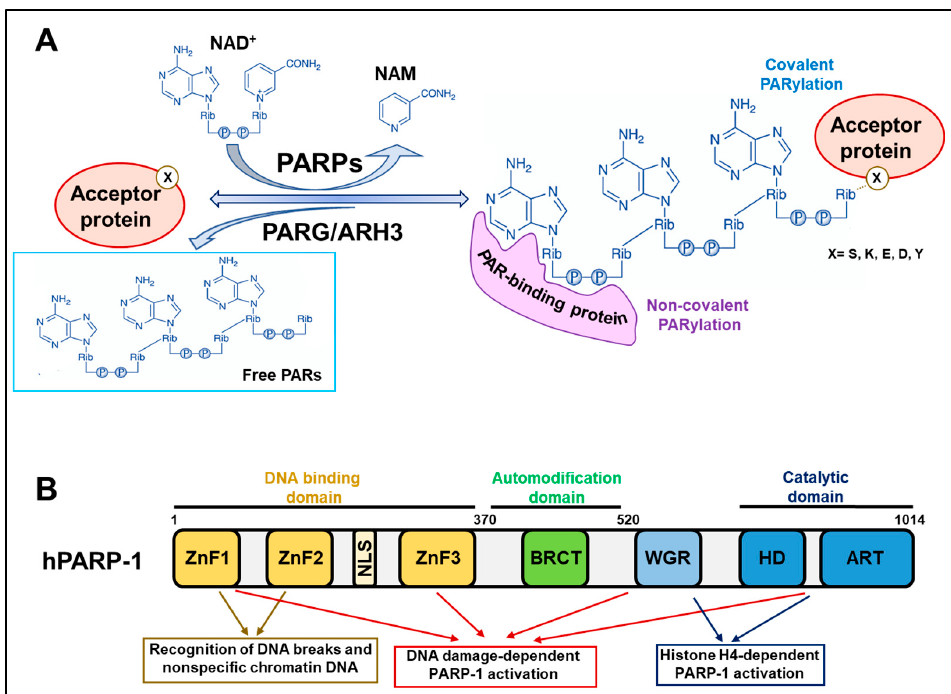
Figure 1 . Structural and functional characteristics of PARP ‐ 1. ( A ) PARP activity mediates covalent PARylation, catalysing the transfer of ADP ‐ ribose moieties from NAD + to several amino acid residues (X) on acceptor proteins releasing nicotinamide (NAM). The reversal reaction is catalysed by PAR ‐ hydrolysing enzymes, including PARG/ARH3. Different protein motifs or domains can recognise and bind PARs non ‐ covalently. ( B ) Schematic representation of the human PARP ‐ 1 molecular structure. The PARP ‐ 1 structure can be subdivided into three major domains: the NH 2 ‐ terminal DNA binding domain, the central automodification domain, and the COOH ‐ terminal catalytic domain. Other subdomains or motifs can be identified in the hPARP ‐ 1 structure: ZnF (zinc finger domain), NLS (nuclear localisation signal), BRCT (BRCA1 C ‐ terminal domain), WGR (Trp ‐ Gly ‐ Arg domain), HD (helical domain), and ART (ADP ‐ ribosyl transferases domain).